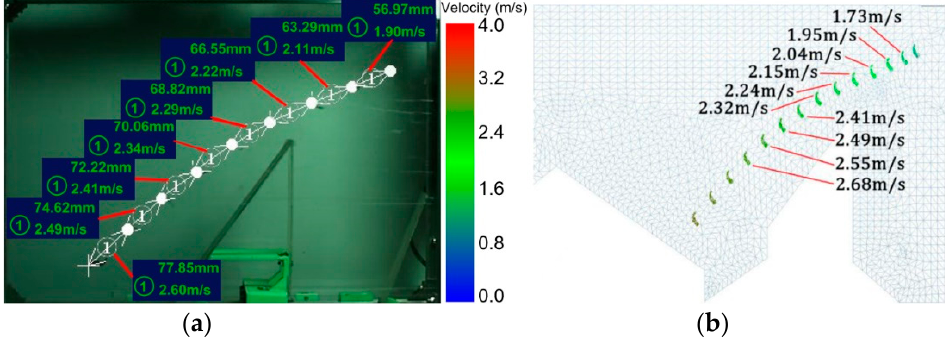
Figure 7. Velocity diagram derived from ( a ) experimental test and ( b ) simulation.